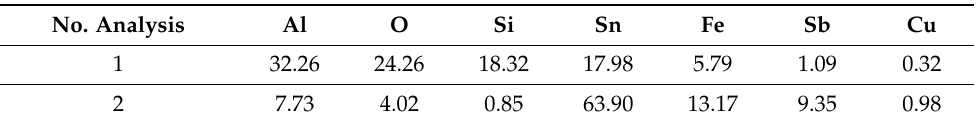
Table 8. EDX analysis of selected zones from Figure 4d on wear surface of hybrid material at a load of 50 N, mass norm., %, after ref. [28].